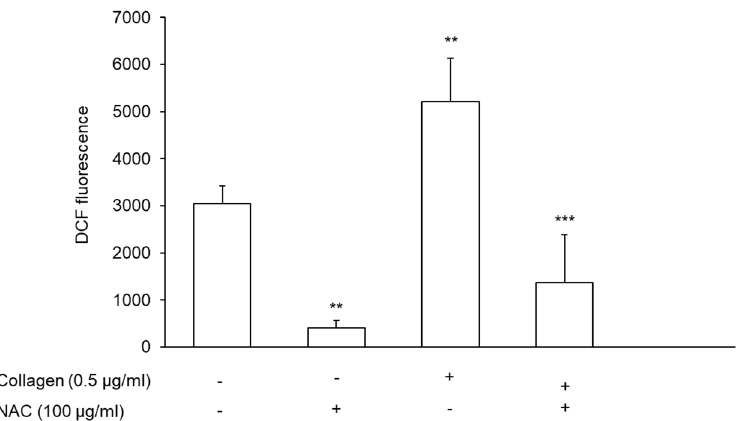
Figure 8. Effect of NAC on the endogenous generation of ROS by platelets. PRP was incubated with DCFH for 1 h at 37 °C. Platelets were precipitated and resuspended in plasma pretreated with vehicle or NAC for 30 min at 37 °C and stimulated with 0.5 μg/mL. Fluorescence was detected 6 min after the addition of collagen. Data are expressed as absorbance of intracellular DCF n = 5. ** p < 0.01 vs. basal; *** p < 0.001 vs. collagen-stimulated platelets for ANOVA and Tuckey’s post hoc test.